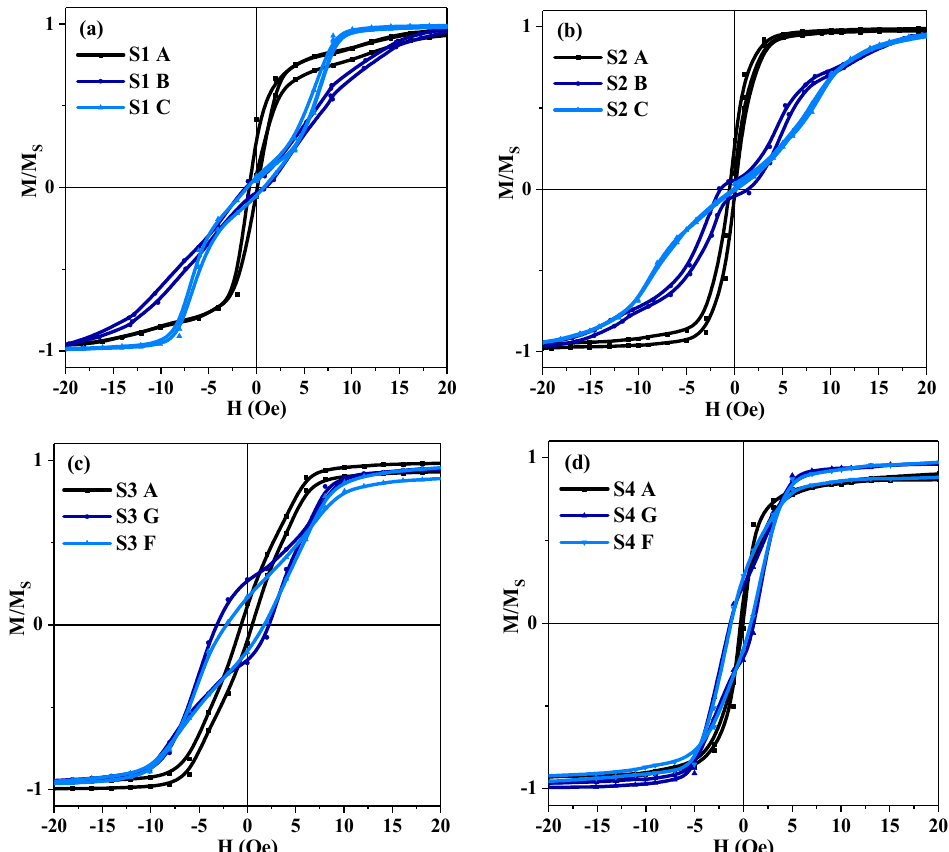
Figure 3. MOKE hysteresis loops taken from the corresponding characteristic sections A, B (G), C (F) of different Co 75 Fe 10 Ni 2 Si 8 B 5 meander samples. The external magnetic field is applied parallel to the long side of the meanders and perpendicular to the induced magnetic anisotropy axis.